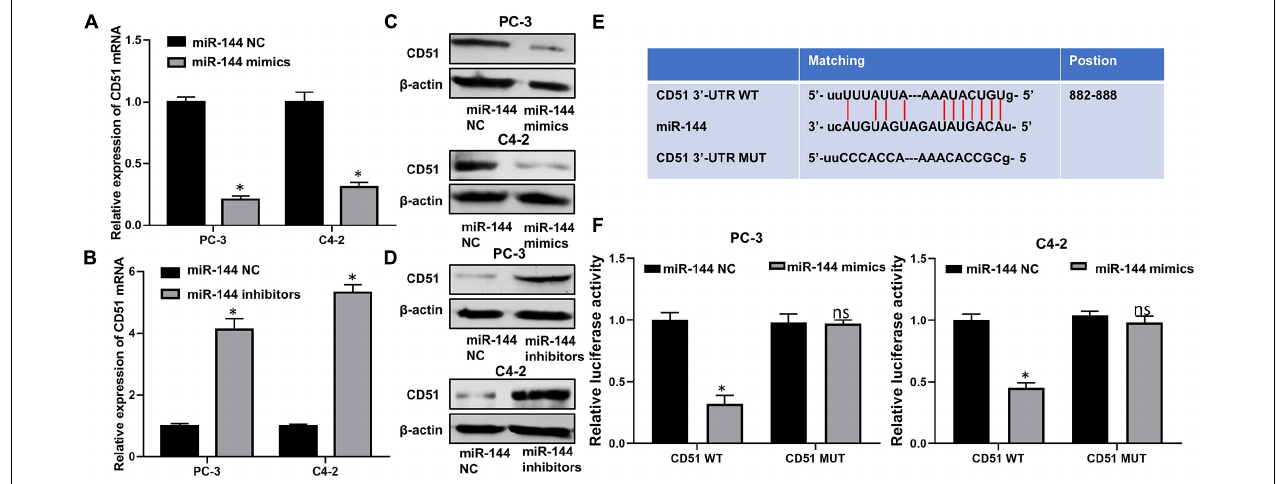
FIGURE 8 | CD51 is a direct target of miR-144 in CRPC cells. (A) Effects of miR-144 mimics on the mRNA levels of CD51 in PC-3 and C4-2 cells, as detected by RT-QPCR; (B) Effects of miR-144 inhibitors on the mRNA levels of CD51 in PC-3 and C4-2 cells, as detected by RT-QPCR; (C) Effects of miR-144 mimics on the protein levels of CD51 in PC-3 and C4-2 cells, as detected by WB; (D) Effects of miR-144 inhibitors on the protein levels of CD51 in PC-3 and C4-2 cells, as detected by WB; (E) Putative binding sequence of miR-144 in 3’-UTR of CD51; (F) Relative luciferase activity of PC-3 and C4-2 cells co-transfected with WT/MUT CD51 plasmid and miR-144 NC/mimics; Data are expressed as the mean ± S.E . * P < 0.05, ns, not significant. The representative results of three independent experiments are